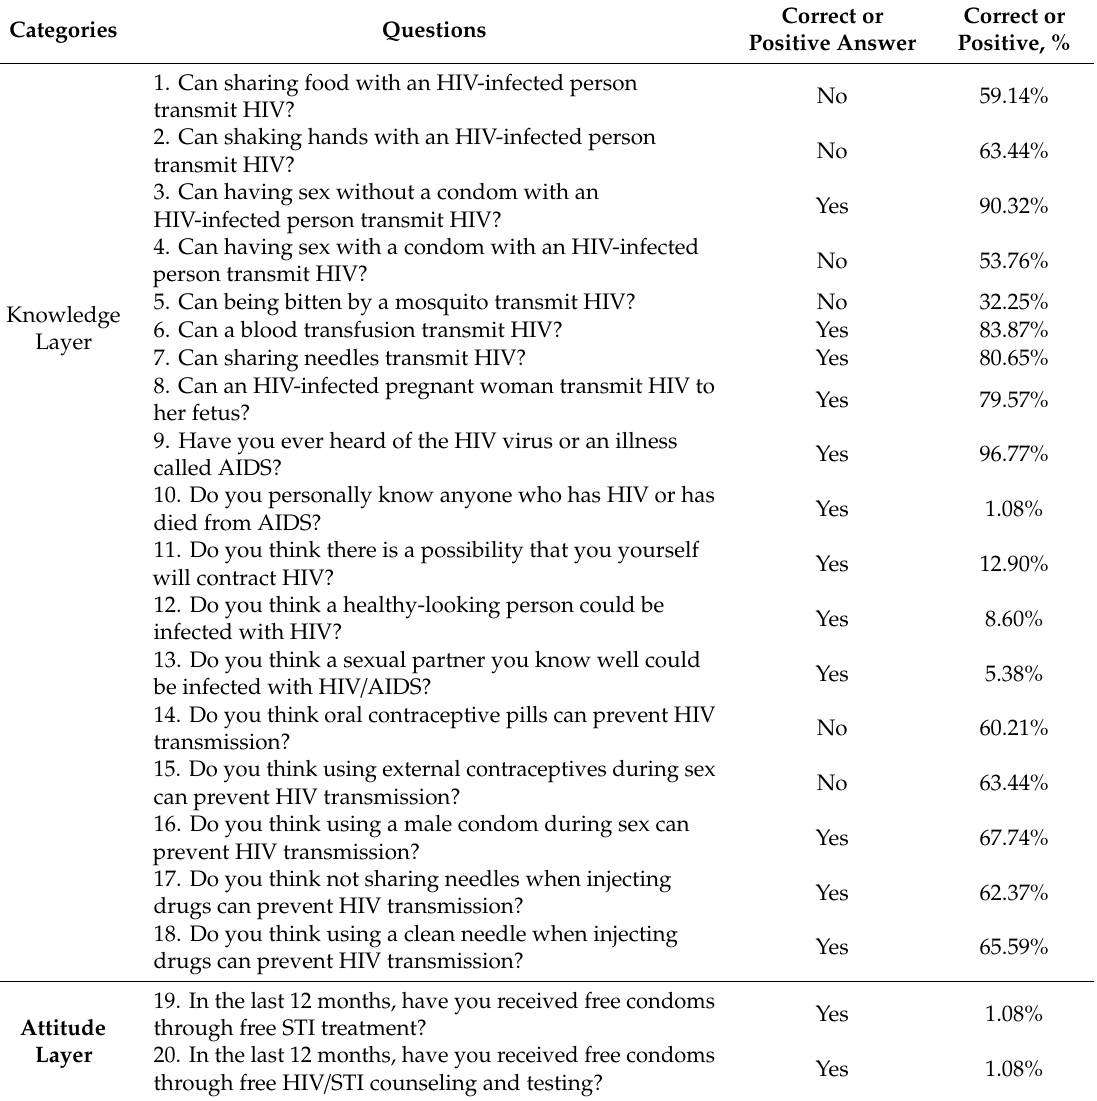
Table A1. Knowledge, attitude, and practice questions on HIV / AIDS transmission, prevention, and control ( n =